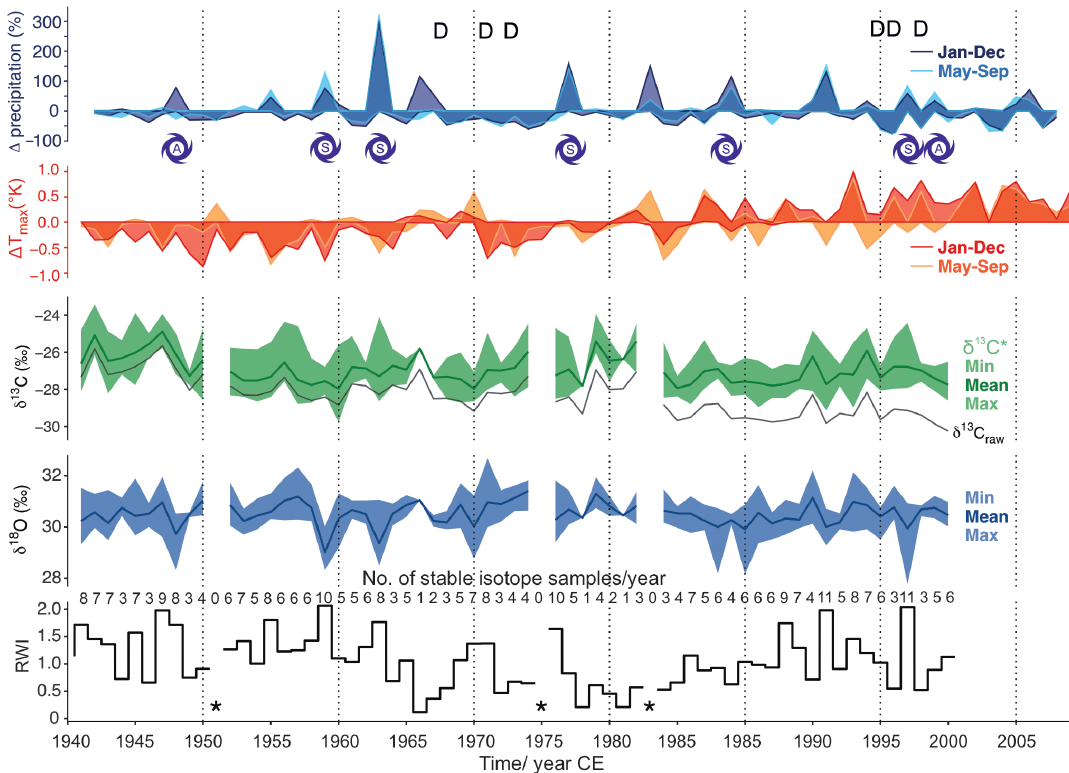
Figure 4. Analyzed baobab tree-ring parameters (ring width indices (RWI), δ 18 O, δ 13 C ∗ ) together with available precipitation and T max data for the period 1941–2014. Precipitation is presented as percentage differences from the mean and T max as differences in Kelvin. Darker colors reflect differences on an annual basis and lighter colors for the monsoon period June–September. The stable isotope values ( δ 13 C ∗ , δ 18 O) are presented with minima, maxima and mean values for each year. Mean δ 13 C, uncorrected for effects of changing atmospheric CO 2 concentration and corresponding δ 13 C CO , is given as a black line ( δ 13 C raw ). Dry years with ≤ 45mm of rain during the monsoon period are 2 marked with D. Years with spring (S) or autumn (A) storms with ≥ 90mm of rain are indicated by cyclone symbols. Missing rings caused gaps in the time series and are marked by